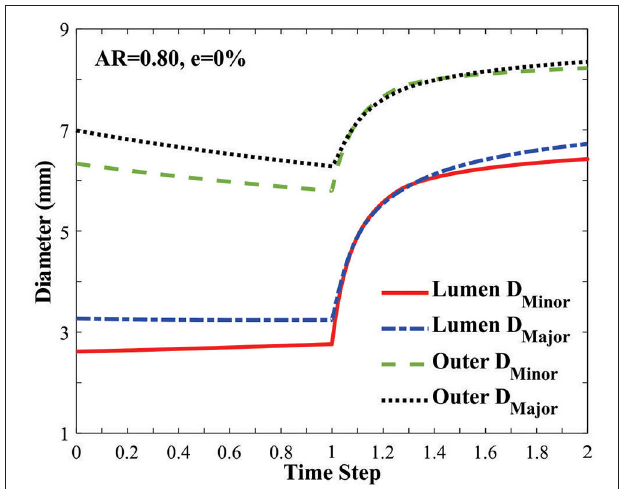
FIGURE 3 | Changes of the minor and major diameters of the lumen and outer wall in an artery with an elliptic cross-section [initial AR = 0.80] under axial stretch (time steps 0–1.0 representing axial stretch ratio 1.0 to 1.3) and lumen pressure (time steps 1.0–2.0 representing lumen pressure 0–50 kPa). The vessel buckled at a lumen pressure of 12.74 kPa (at time step 1.25).